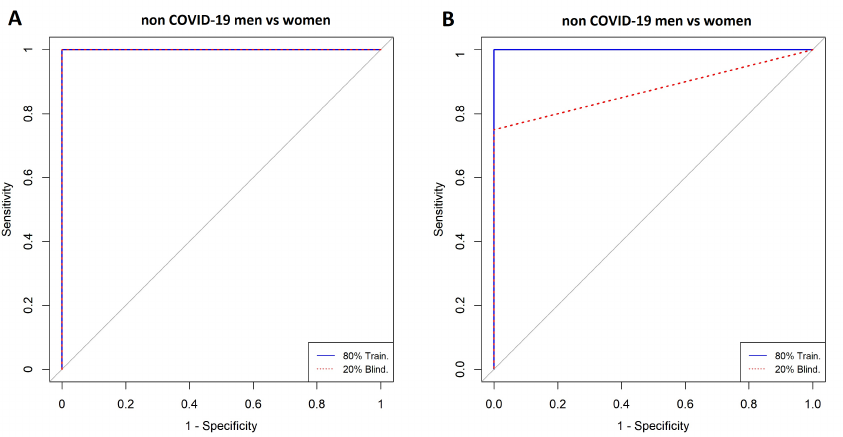
Figure A6. ROC curves for the classification of non-COVID-19 men and women ( A ) logistic regression and ( B ) support vector machine models. Table A2. Evaluation criteria for logistic regression model with all factors and support vector machine for non-COVID-19 men and women